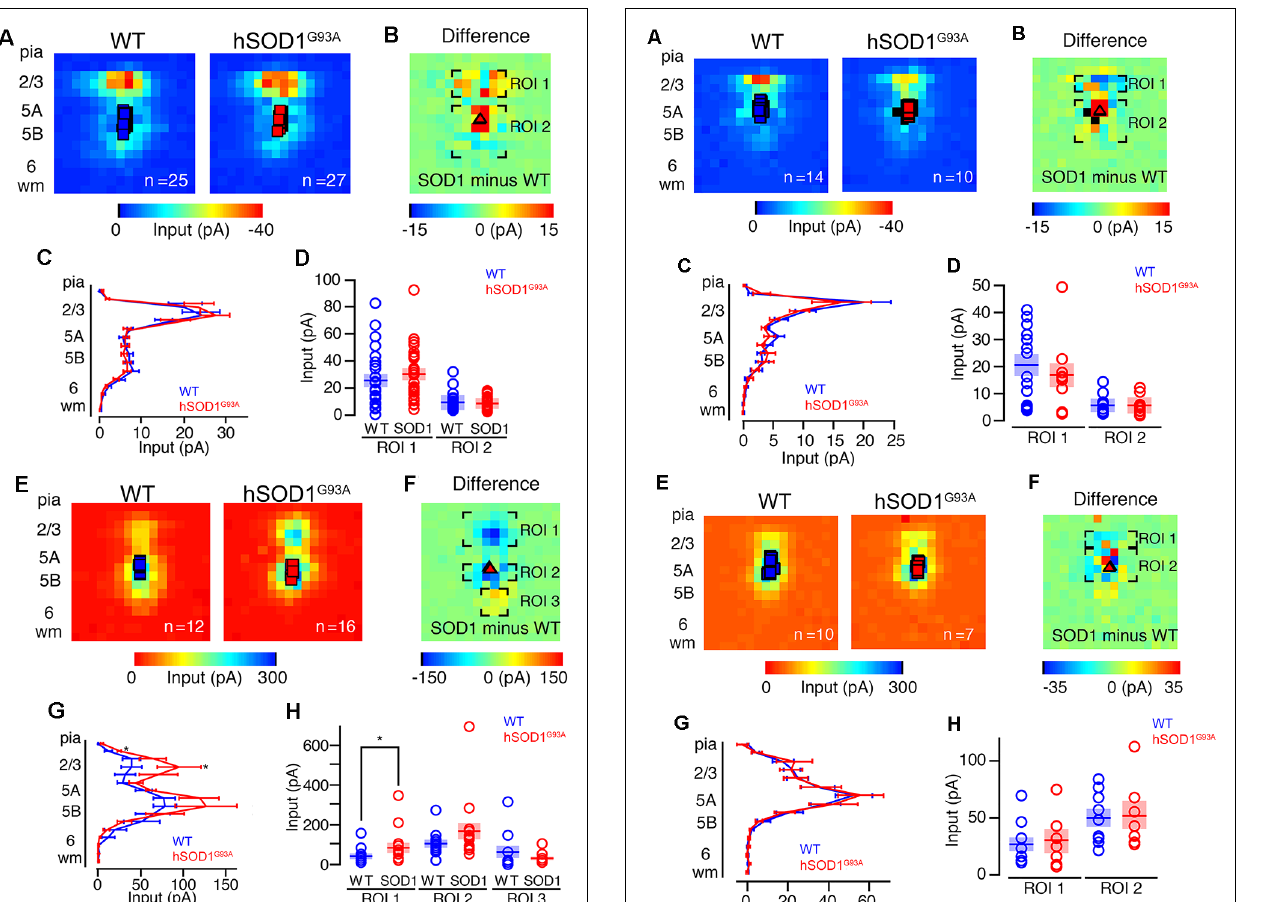
no difference in L2/3 excitatory input for both row average ( Figure 3C ) and region-of-interest analysis ( Figure 3D ). As with CSMN, we found inhibitory responses following stimulation of L2/3 and L5 for CPN both in L5A of WT and hSOD1 G93A mice ( Figure 3E ). Analysis of inhibitory input maps recorded from CPN in hSOD1 G93A ( n = 7) and WT ( n = 10) mice ( Figure 3F ) also revealed comparable results between genotypes, further suggesting that the stronger inhibition observed in L2/3 of the motor cortex of hSOD1 G93A mice was specific to CSMN ( Figures 3G,H